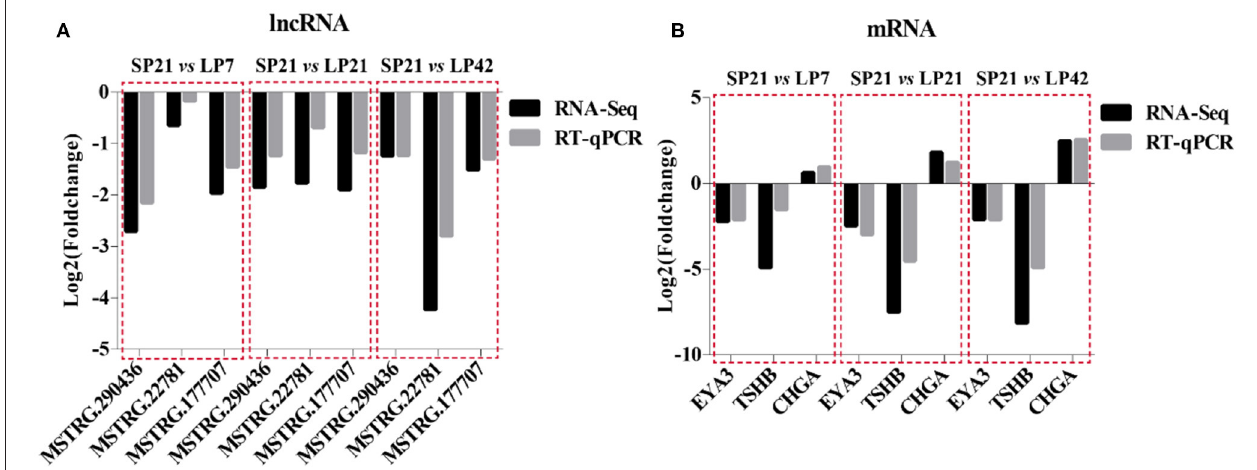
FIGURE 9 | Validation of RNA-Sequencing (RNA-seq) data using RT-qPCR. (A) RNA-Seq and RT-qPCR results of three selected differentially expressed lncRNAs in PT of Sunite sheep at different photoperiods. (B) RNA-Seq and RT-qPCR results of three selected differentially expressed mRNAs in PT of Sunite sheep at different